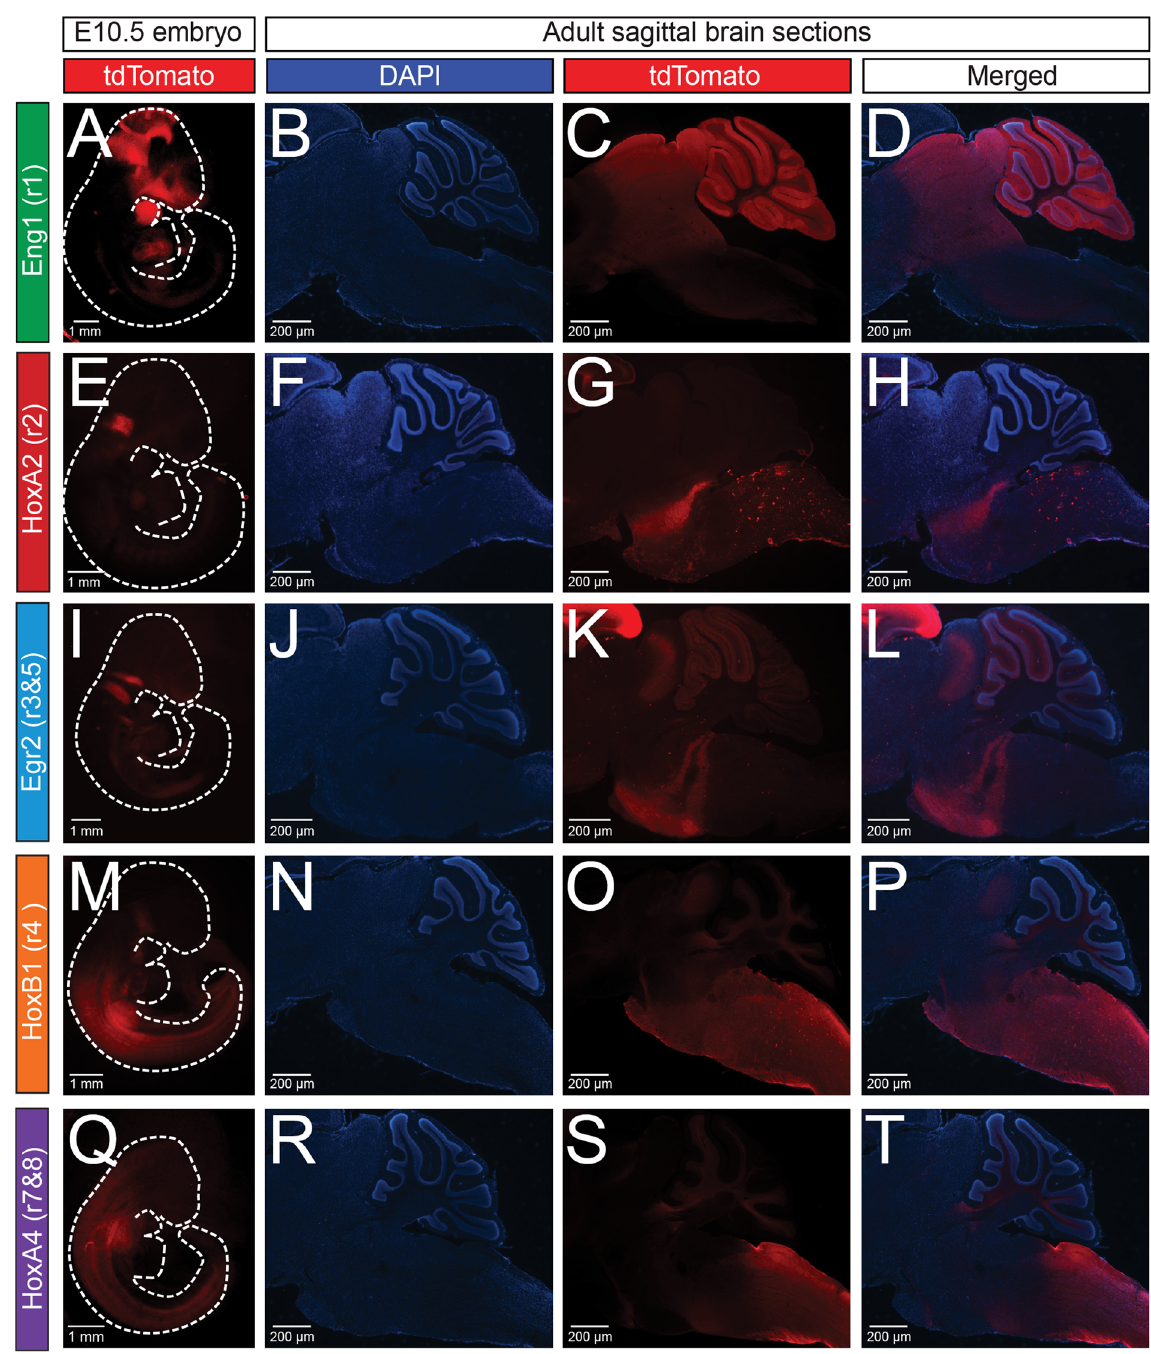
Figure 2. The Eng1 Cre , HoxA2-Cre , Egr2 Cre , HoxB1 Cre , and HoxA4-Cre drivers capture broad rhombomeric domains in the embryo and adult. The five rhombomere-specific-Cre lines were crossed with Ai9 mice to express tdTomato in a Cre-specific manner. In column 1, rhombomere-Cre; Ai9 E10.5 whole embryos were cleared using hydrogel cross-linking followed by lipid extraction by SDS treatment. In columns 2–4, DAPI and tdTomato fluorescence of sagittal brainstem cryosections (30 μ m) from adult rhombomere-Cre; Ai9 animals are shown. Embryo and adult expression can be seen in the Eng1 Cre (A–D) , HoxA2-Cre ( E–H) , Egr2 Cre (I–L) , HoxB1 Cre (M–P) , and HoxA4-Cre (Q–T )